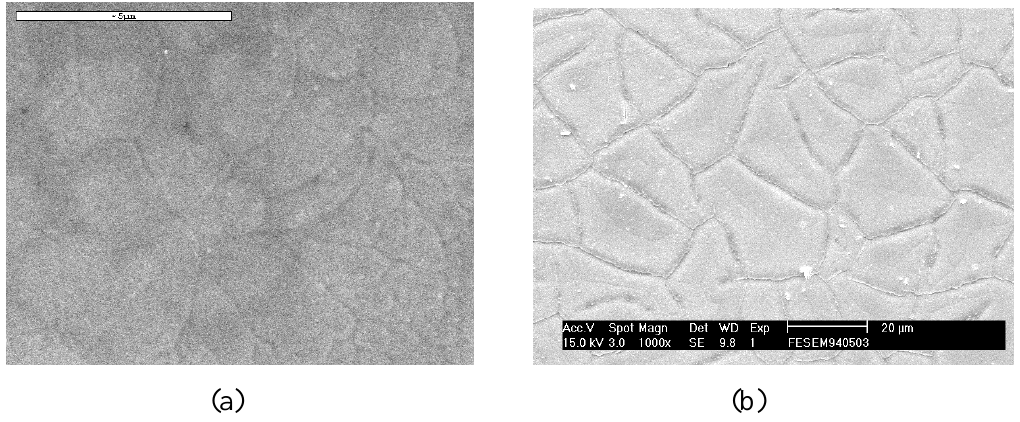
Figure 3. Surface morphology of PZT films (a) 2 µ m-thick (b) 10 µ